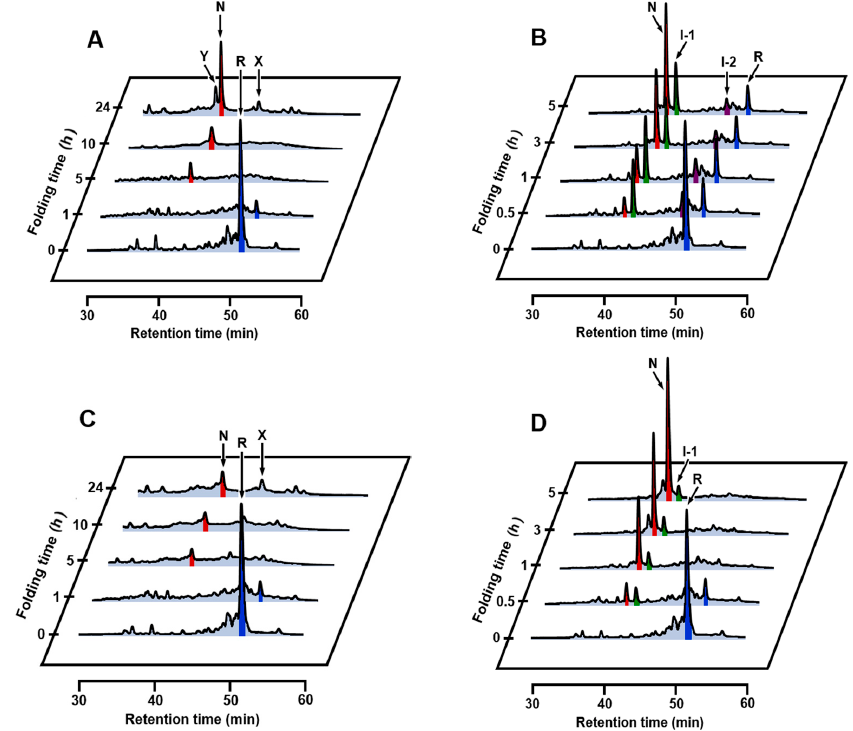
Figure 8. RP-HPLC chromatograms obtained by the oxidative folding of α LA using 1 eq DHS ox at pH 8.0 and 35 or 45 °C in the absence or presence of CaCl 2 . The initial concentration of R was 10 µM. The folding intermediates were trapped at different reaction times by acidification. ( A ) at 35 °C in the absence of CaCl 2 ; ( B ) at 35 °C in the presence of 5 mM CaCl 2 ; ( C ) at 45 °C in the absence of CaCl 2 ; ( D ) at 45 °C in the presence of 5 mM CaCl 2 .